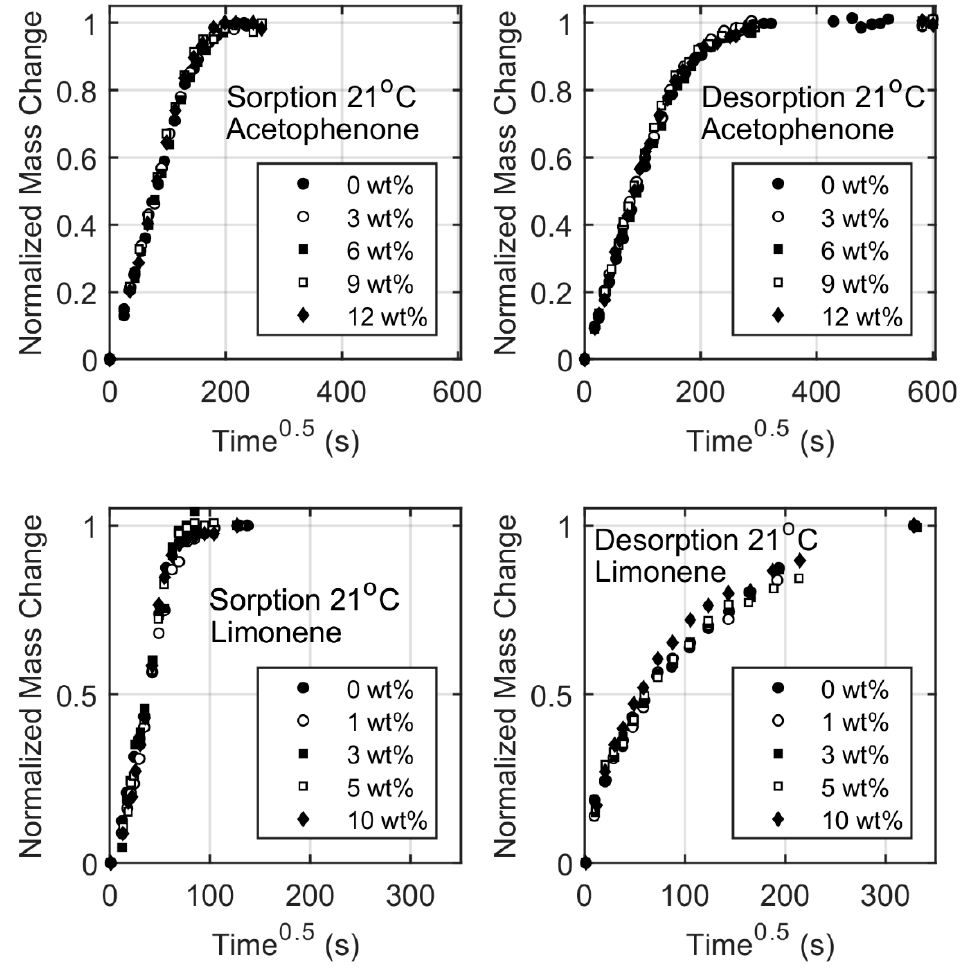
Figure 4. Sorption ( left ) and desorption ( right ) in C 8 -Al 2 O 3 nanocomposites at 21 °C. Acetophenone ( upper ) and limonene ( lower ( upper ) and limonene ( lower ).